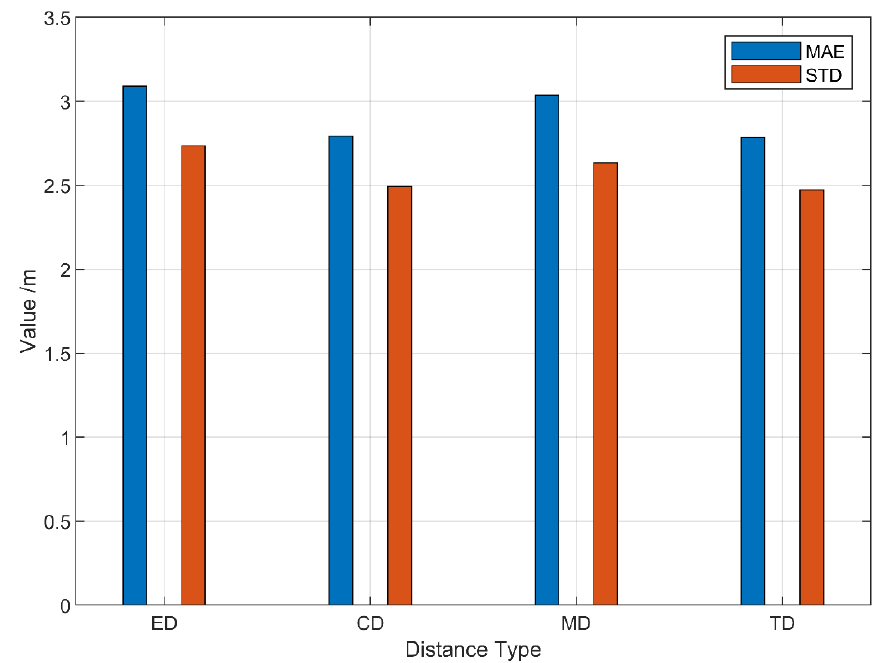
Figure 10. Positioning errors based on ED, CD, MD, and TD, respectively.